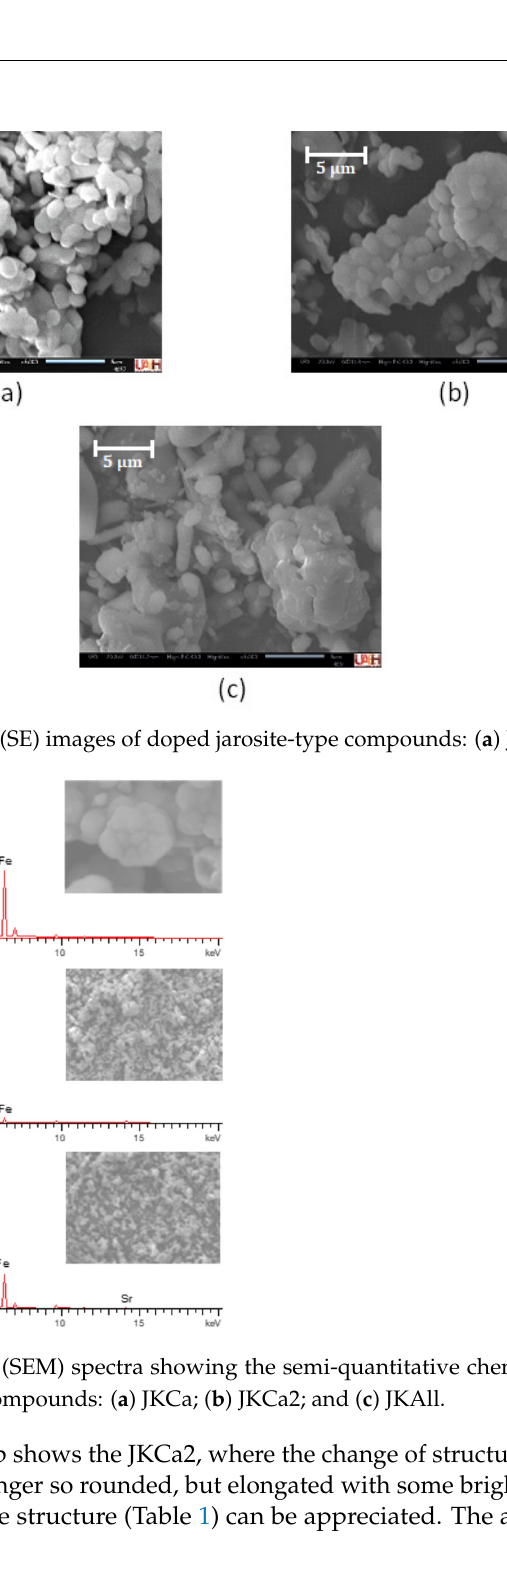
Table 1. Semi-quantitative chemical composition by energy dispersive spectrometry analysis in jarosite samples (weight percentage, %